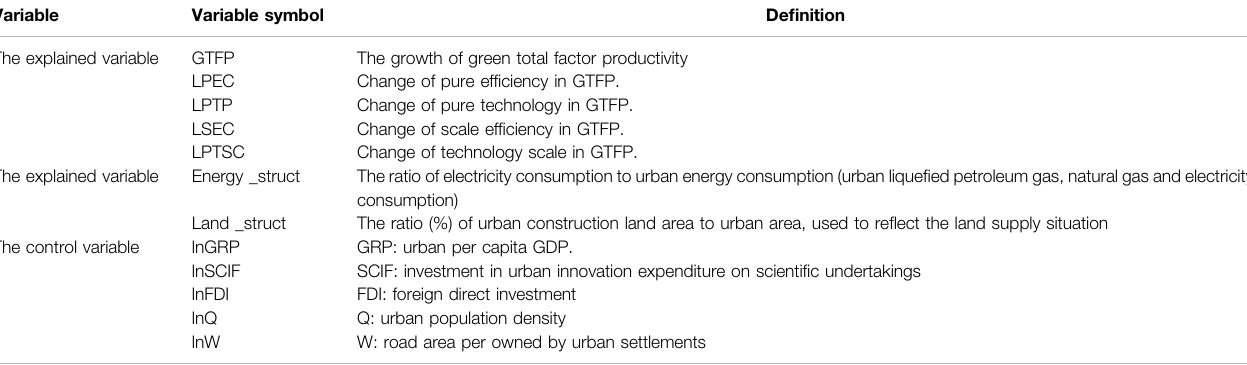
TABLE 5 | De fi nition of variables in Function 20. Variable Variable symbol